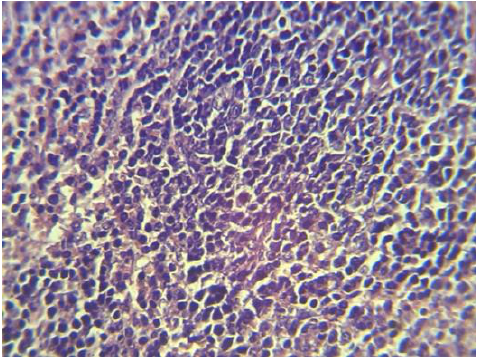
Figure, 1: Histopathological section in the spleen of immunized animal with sonicated Ags shows proliferation of lymphocytes in the periarteriol sheath and proliferation of mononuclear cells around sinuses (H&E stain 40X).